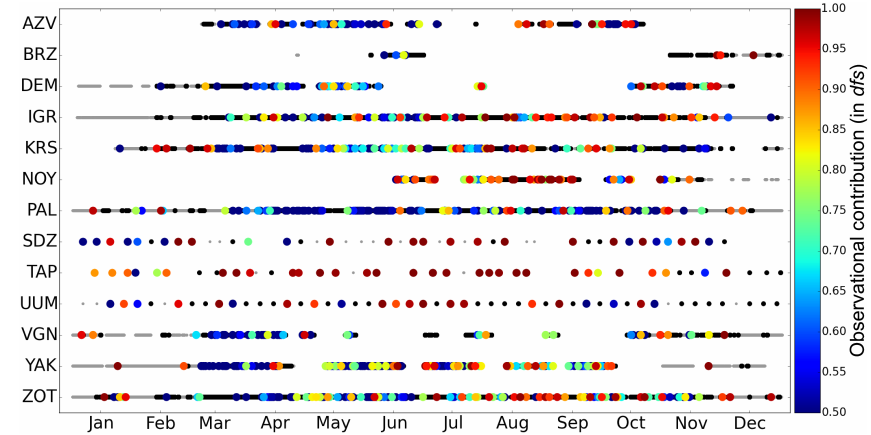
Figure 2. Observation availability and contribution in dfs to the inversion for each site. Grey dots stand for available data flagged out because of a planetary boundary layer height smaller than 500m. Black dots denote the data points that are filtered during the computation of the algorithm described in Sect. 2 and 3.1. Colour circles represent the pieces of information carried out by each selected piece of data (see Sect.